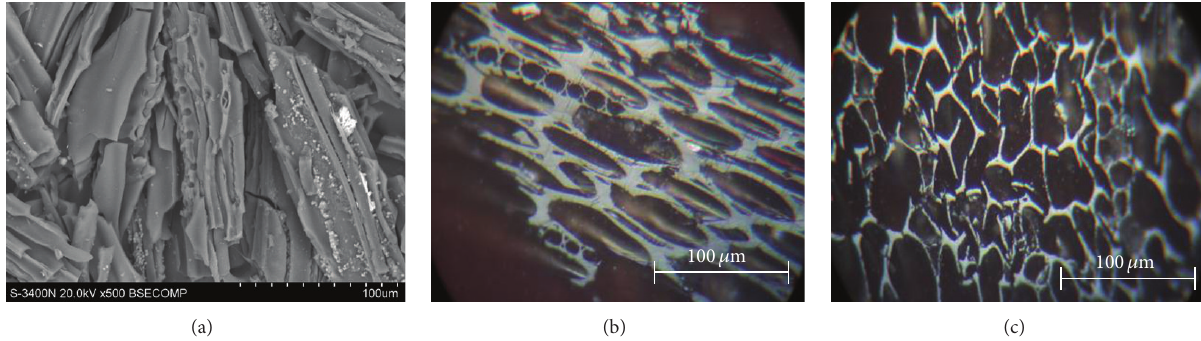
Figure 3: (a) SEM image of fusinitic coal (scale = 100 𝜇 m), (b) reflection microscopic image of a longitudinal section of fusinite (scale = 100 𝜇 m), and (c) reflection microscopic image of a transverse section of fusinite (scale = 100 𝜇 m).